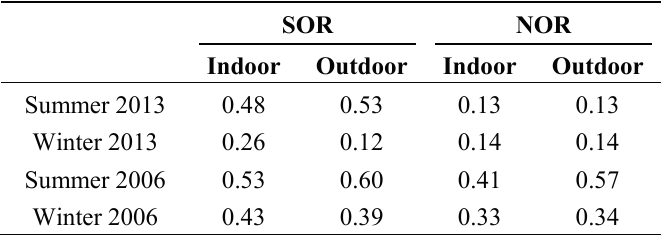
Table 4. Sulfur oxidation ratio (SOR) and nitrogen oxidation ratio (NOR) inside and outside the Pit No. 1 Display Hall of Emperor Qin’s Terra-cotta Museum during the summer and winter sampling campaigns from 2006 [24] to